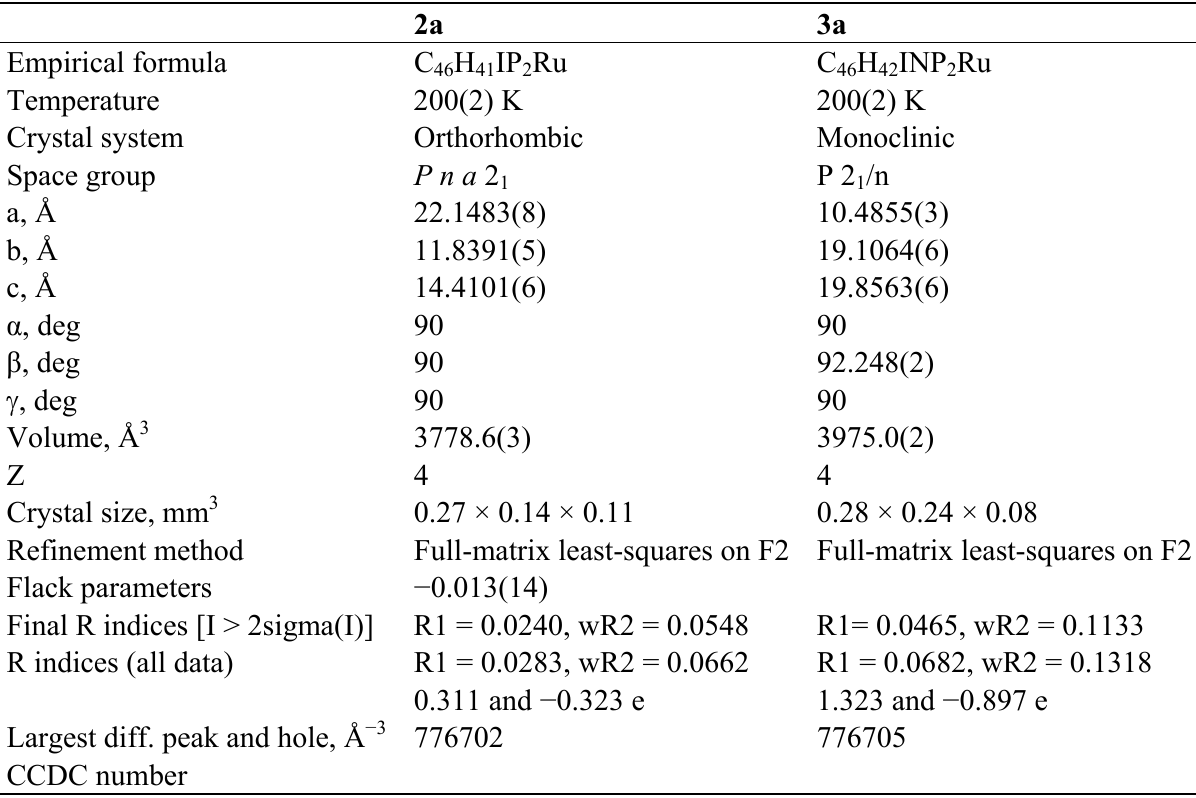
Table 3. Crystal data and refinement parameters for complexes 2a and 3a